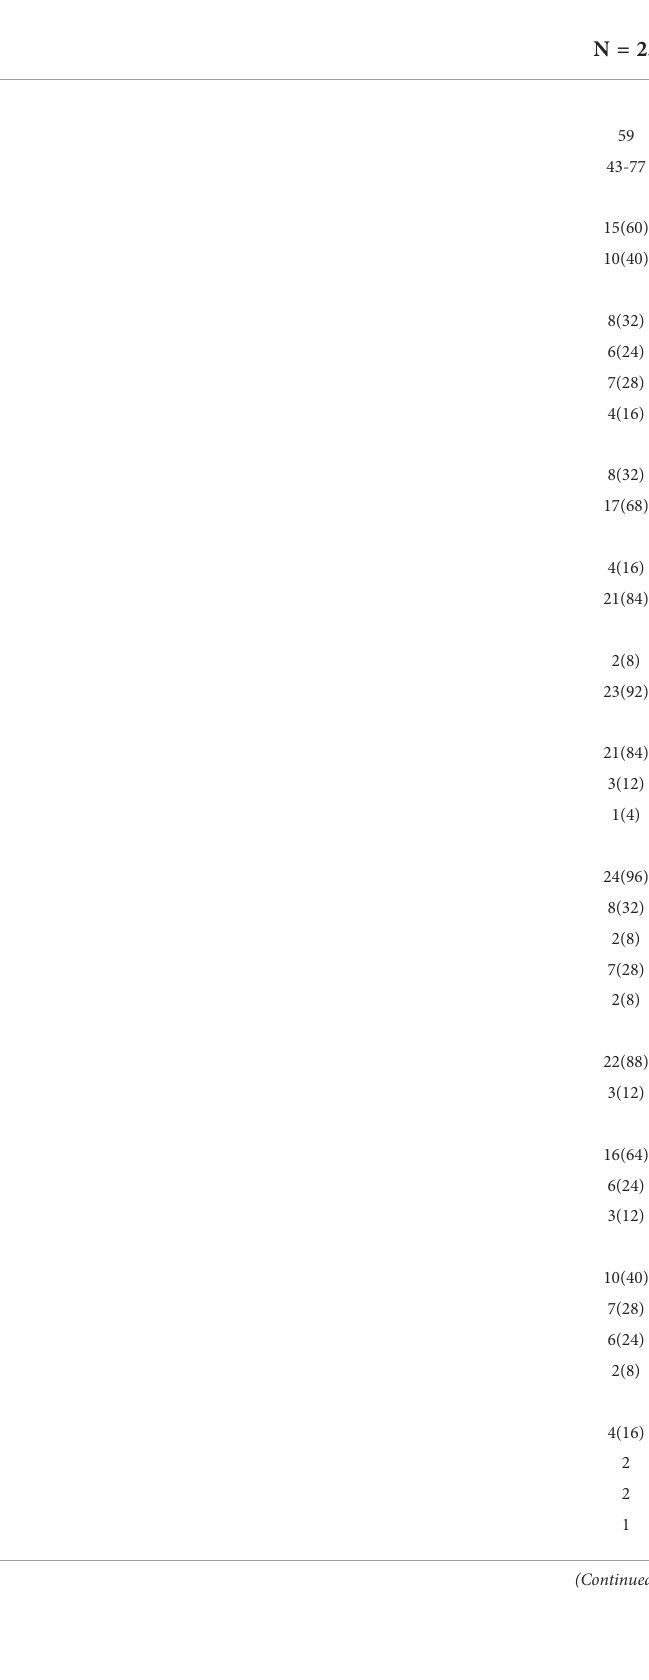
TABLE 1 Demographic and clinical